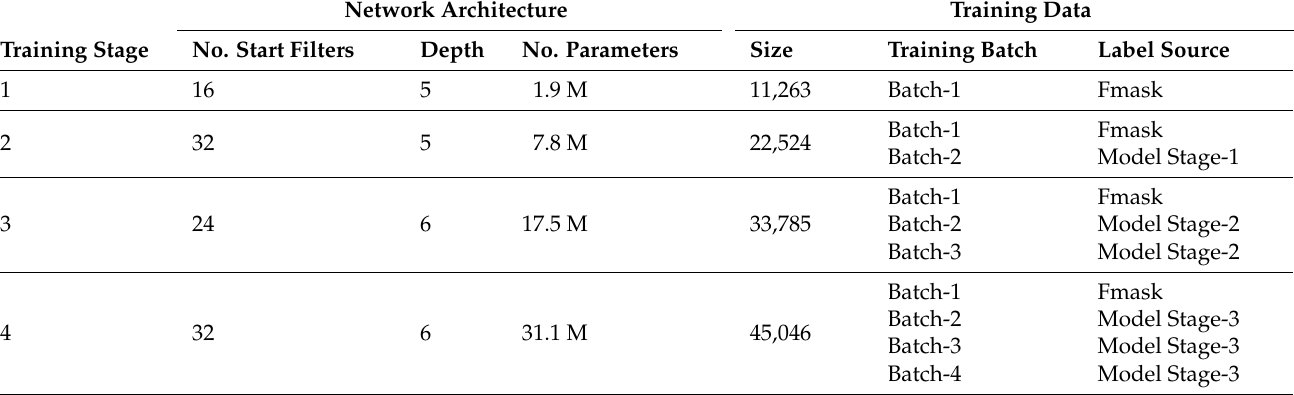
Table 3. Network architecture and training data used at each stage of the iterative approach. The number of parameters in the network at each stage was controlled using the number of start filters and depth hyperparameters. The size of the training dataset given below was the number of 254 × 254 image